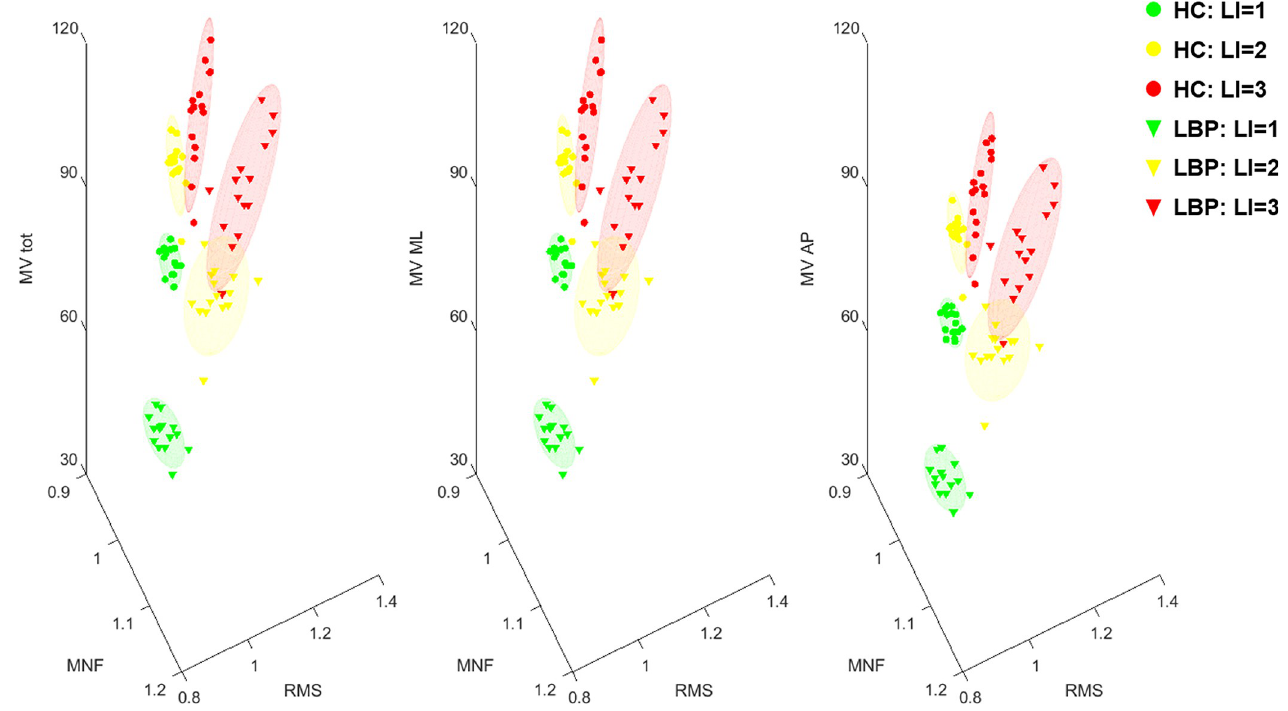
Fig 7. Relation between CoP and EMG parameters. 3D plot of the Centre of Pressure (CoP) parameters and EMG parameters for both HC and LBP groups. Each point represents the group average extracted every minute (across the 15 minutes lifting). RMS: root mean square of the erector spinae muscle; MNF: mean frequency of the erector spinae muscle; MV, MV ML and MV AP : mean velocity for the 2D CoP motion and along the ML and AP directions; HC: healthy control; LBP: people with Low Back Pain.